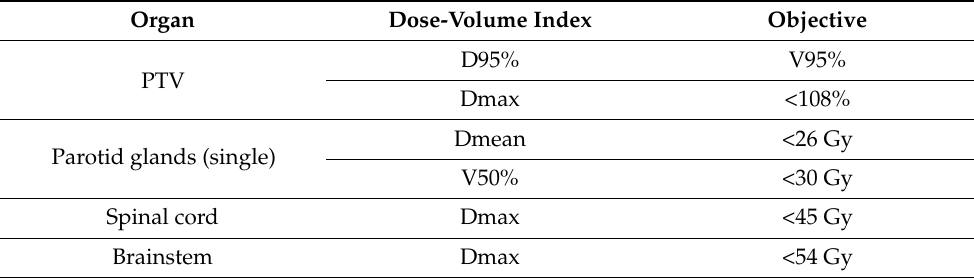
Table 2. Dose constraints used to create the treatment plan. Organ Dose-Volume